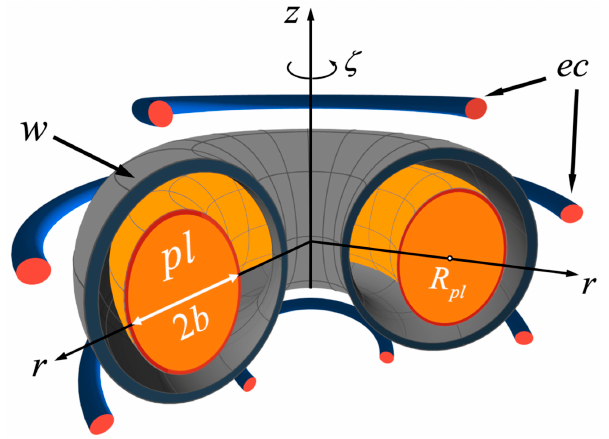
Figure 1. Schematic view of a large aspect-ratio tokamak with vertically elongated plasma of major and minor radii R pl and b , respectively. The plasma is marked as pl , ec corresponds to external coils , and w denotes the wall .